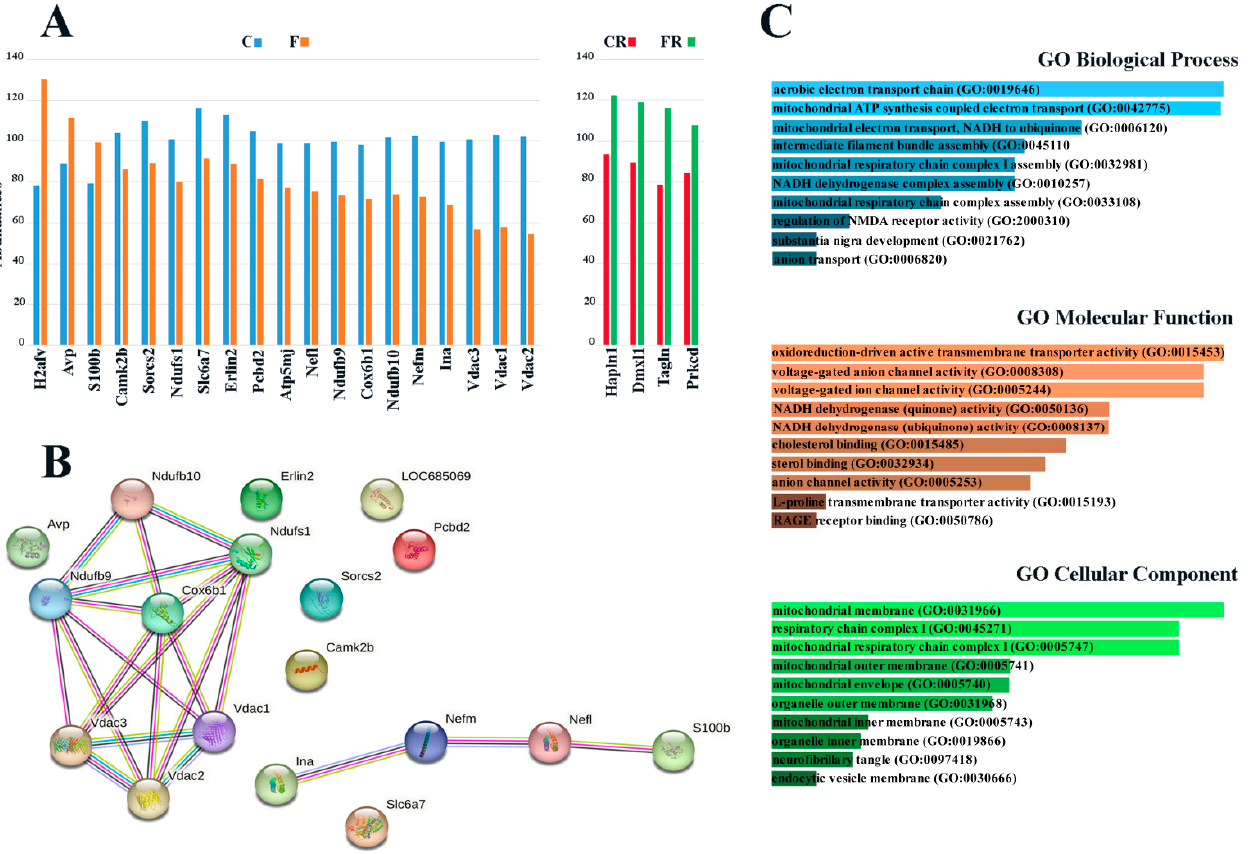
Figure 2. Proteomic analysis of rat hypothalamus. ( A ) Proteins showing quantitative changes in the comparison of fructose-fed adolescent (F, orange) versus control adolescent (C, light blue) rats, and young-adult fructose-rescued (FR, green) versus young-adult control rescued (CR, red) rats. Differentially represented proteins are indicated using corresponding gene names. ( B ) STRING analysis of differentially represented proteins present in F versus C fed rats. Functional protein associations were based on data recorded for R. norvegicus . Only medium-confidence interactions (0.4) are shown. Sorcs2, sortilin-related VPS10 domain containing receptor 2; Ndufs1, NADH-ubiquinone oxidoreductase 75 kDa subunit, mitochondrial; Atp5mpl (Atp5mj), mitochondrial membrane ATP synthase F (1) F (0); Camk2b, calcium/calmodulin-dependent protein kinase type II, subunit beta; S100b, protein S100-B; Ndufb10, NADH:ubiquinone oxidoreductase subunit B10; Vdac2, voltage-dependent anion-selective channel protein 2; Vdac1, voltage-dependent anion-selective channel protein 1; Ndufb9, NADH dehydrogenase (ubiquinone) 1 beta subcomplex 9; Slc6a7, solute carrier family 6 (neurotransmitter transporter, l-proline) member 7; Avp, vasopressin-neurophysin 2-copeptin; Nefl, neurofilament, light polypeptide; Erlin2, ER lipid raft associated 2; Cox6b1, cytochrome c oxidase, subunit VIb polypeptide 1; Vdac3, voltage-dependent anion-selective channel protein 3; LOC685069, H2A histone family, member V; Ina, internexin neuronal intermediate filament protein, alpha; Nefm, neurofilament, medium polypeptide; Pcbd2, 4a-hydroxytetrahydrobiopterin dehydratase. ( C ) Functional enrichment analysis of differentially represented proteins in F versus C fed rats. GO terms for biological process (upper panel), molecular function (middle panel) and cellular component (lower panel) are reported.